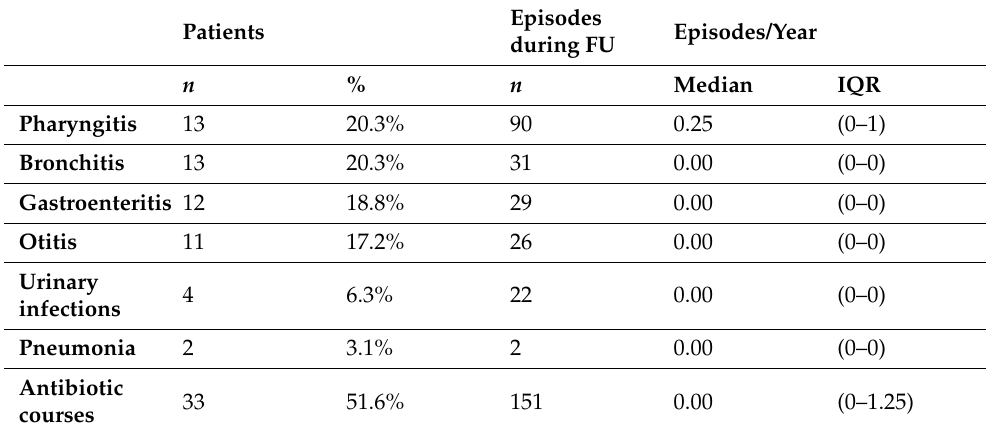
Table 2. Incidence of infectious manifestations in 67 patients with SIgAD during